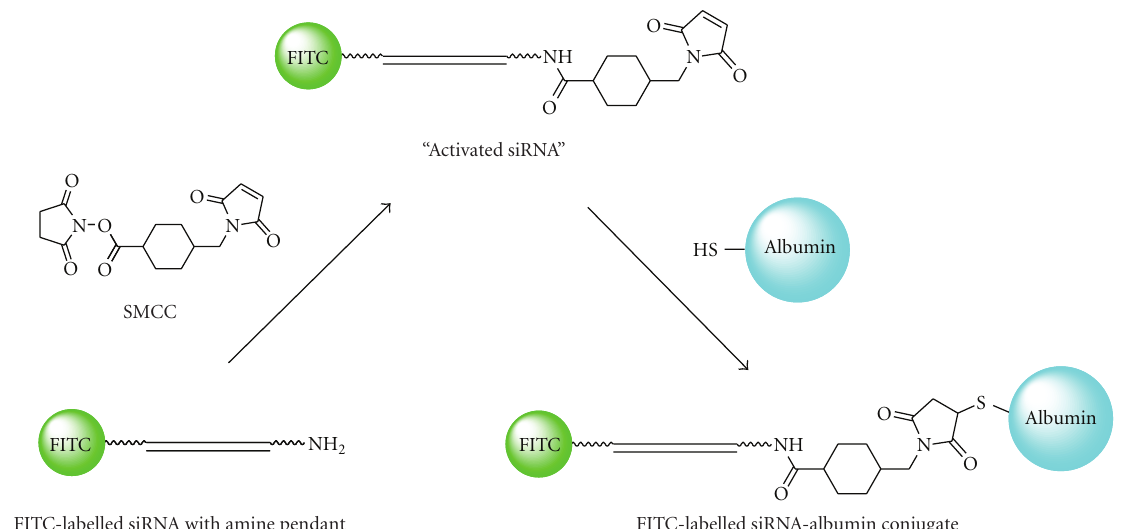
Figure 1: Conjugation chemistry. Formation of an amide bond between the heterobifunctional cross-linker SMCC and commercially sourced amine-modified siRNA produces maleimide-functionalized siRNA (activated siRNA). The activated siRNA reacts with cysteine- 34 of BSA to produce an siRNA-BSA